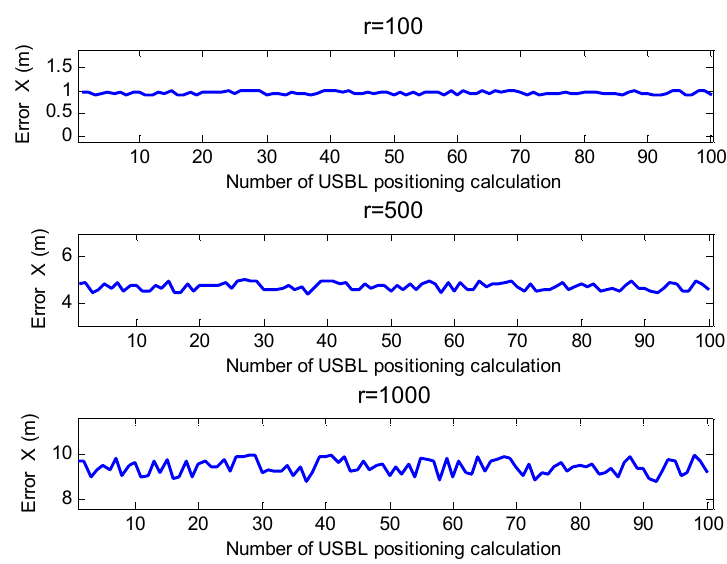
Figure 14 Horizontal positioning error at different positioning distances (based on the slant range and azimuth method).